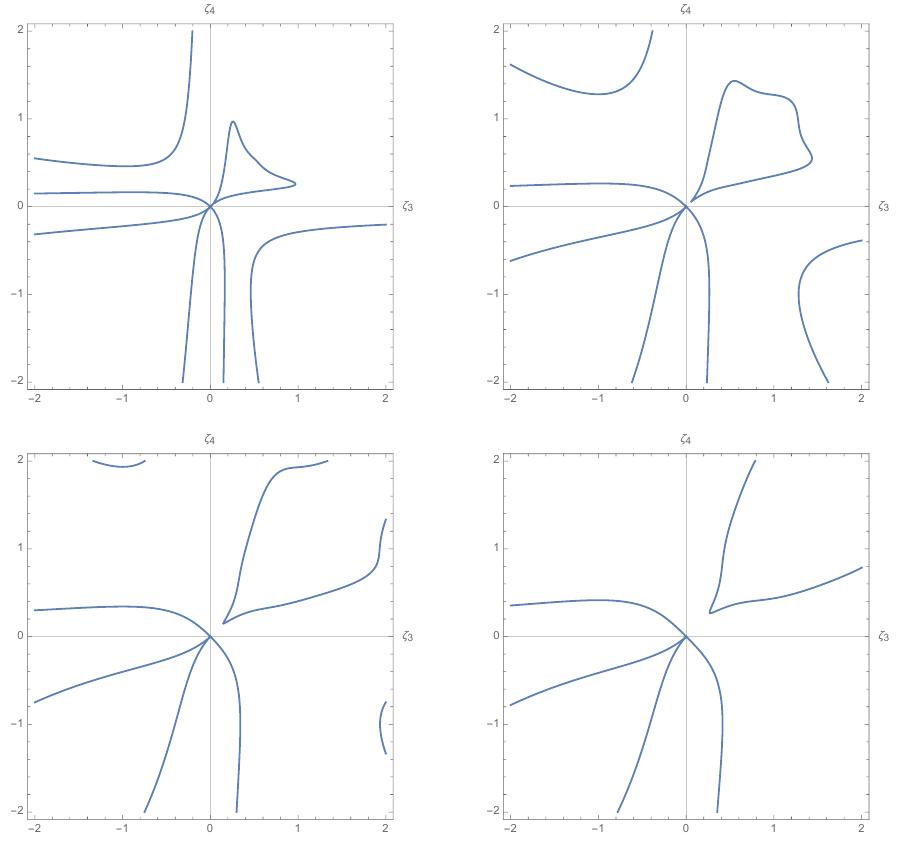
Figure 1 . Sections of the loci of planar zeros P (cid:30) 3